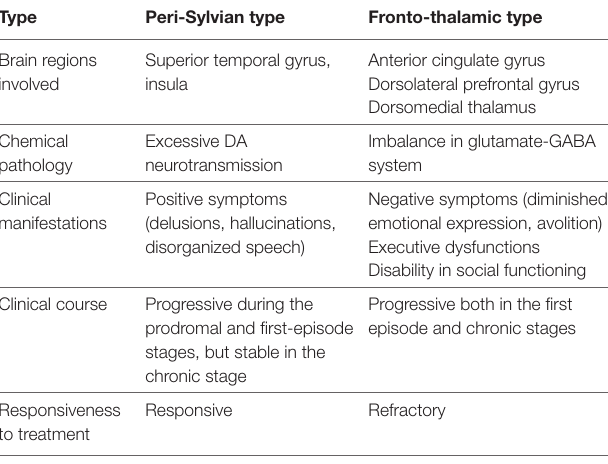
TABLe 2 | Pathophysiological modeling of